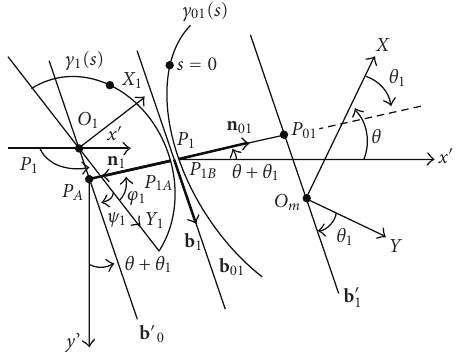
Figure 3: Rolling contact constraint is expressed by equalizing the velocity of contact point P 1 A ( = P 1 ) in the direction of the unit tangent vector b 0 with that of P 1 B ( = P 1 ) in the same direction of b 1 . The velocity of P 1 A in the direction of the normal n 1 should be equal to that of P 1 B in the same direction. It is therefore assumed that b 0 = b 1